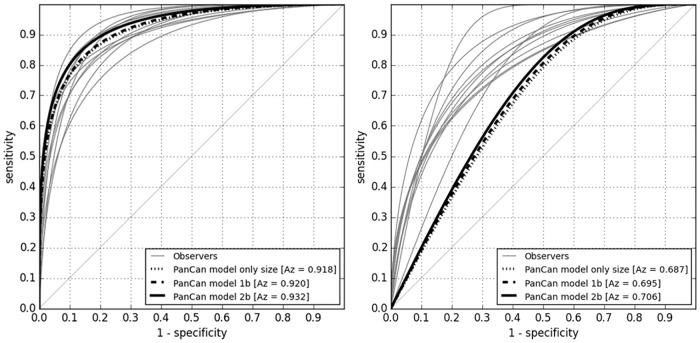
Performance of observers and PanCan model.ROC curves of the observers 1–11, the PanCan model 2b, the PanCan model 1b, and only nodule size as predictor for (A) discriminating randomly selected benign nodules from malignant nodules on the left, and (B) on the right discriminating size-matched benign nodules from malignant nodules. Note that in Fig 1A the PanCan model outperforms human observers at a specificity > 80%, while in Fig 1B all human observers perform better than the PanCan model.